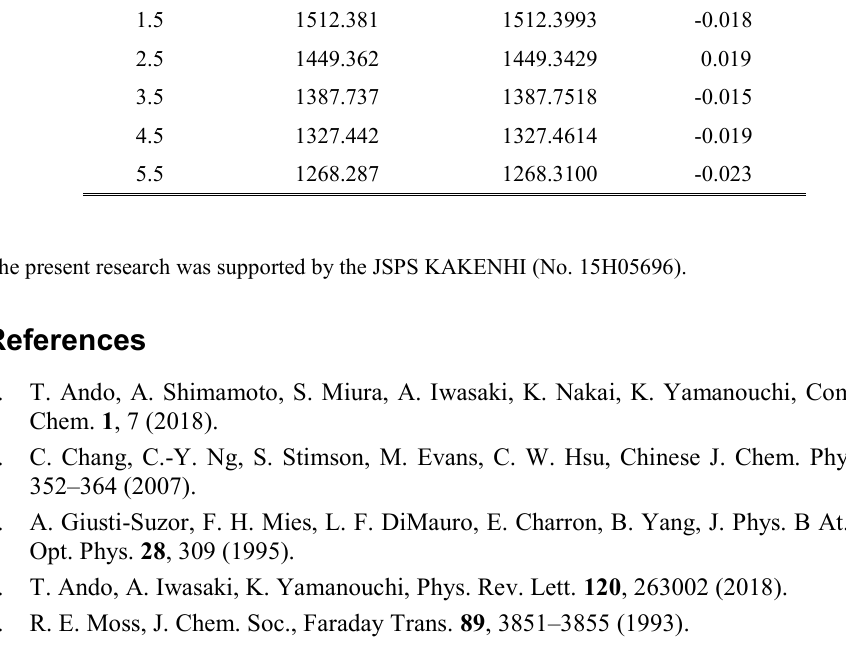
Table 1. Comparison between the observed and calculated vibrational energy spacings (cm -1 ),  G ( v + 1/2), of D 2+ . v + 1/2 Obs. Calc. [5] Obs. – Calc. 0.5